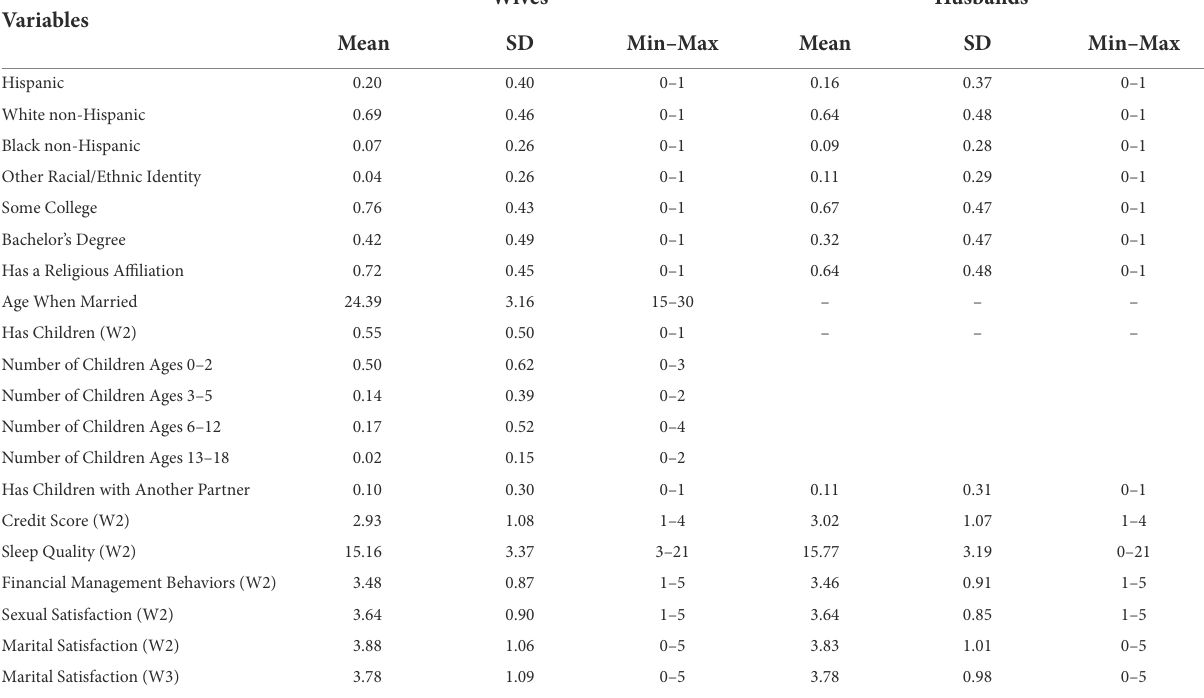
TABLE 1 Descriptive statistics and demographic variables split by sex (N = 1,001